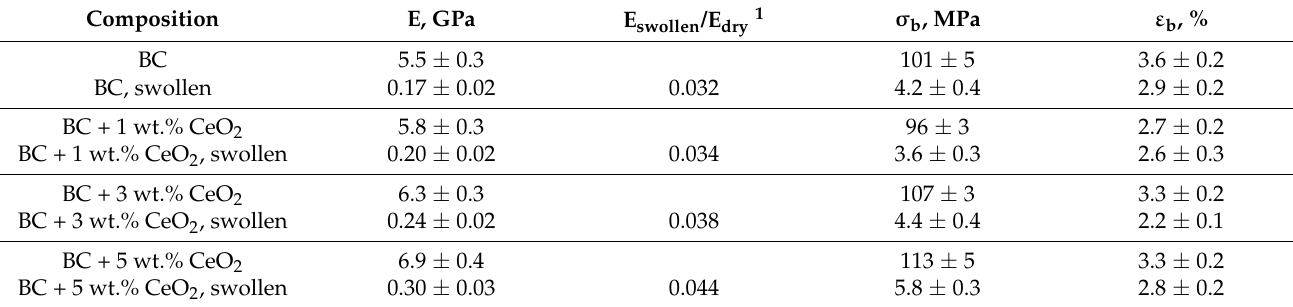
Table 2. Mechanical characteristics of bare BC and BC-CeO 2 composite